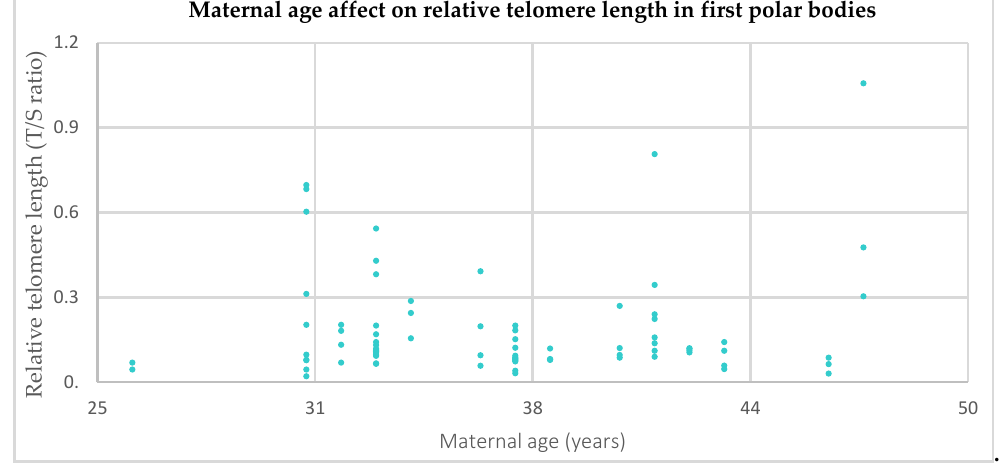
Figure 1. Average relative telomere length of all first polar bodies from women aged 35 years old or under ( n = 13) compared to women of advanced maternal age ( n = 12). Results show that telomere length is slightly shorter in first polar bodies from women above 35 years old, however, this difference is not statistically significant ( p = 0.35). The line on the lower end of the whisker represents the minimum T/S ratio, the bottom of the box represents the first quartile, the line through the middle region of the box represents the median T/S ratio, the top of the box represents the third quartile, and the line at the top of the whisker represents the maximum T/S ratio. Circles represent outliers between 1.5 and 3 box lengths from the upper region of the box. Asterisks represent extreme outliers that are more than 3 times the interquartile range from the third quartile.